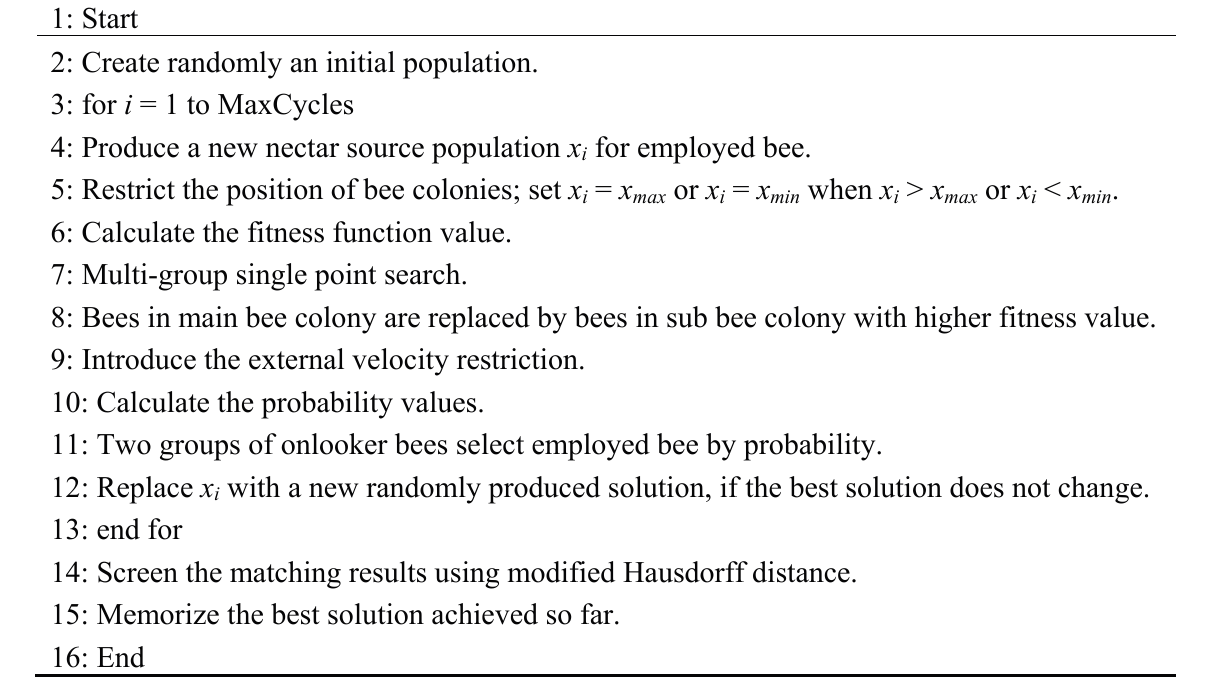
Table 2. Improved ABC Algorithm with single point search and constrained